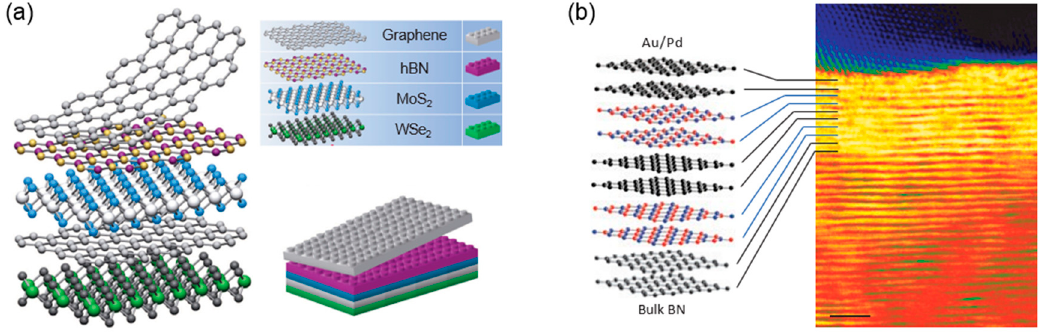
Figure 3. ( a ) Schematic diagram of 2D vdW heterostructures composed of graphene, h ‐ BN, and TMDCs [51]; and ( b ) cross ‐ sectional scanning transmission electron microscopy (STEM) image of a graphene/ h ‐ BN heterostructure. Reproduced with permission from [51] and [70]. Copyright